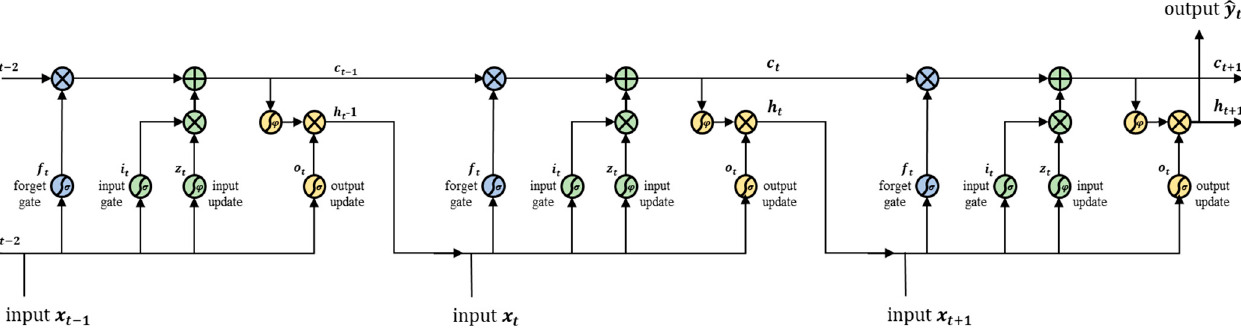
Figure 5. The RNN and LSTM structures.